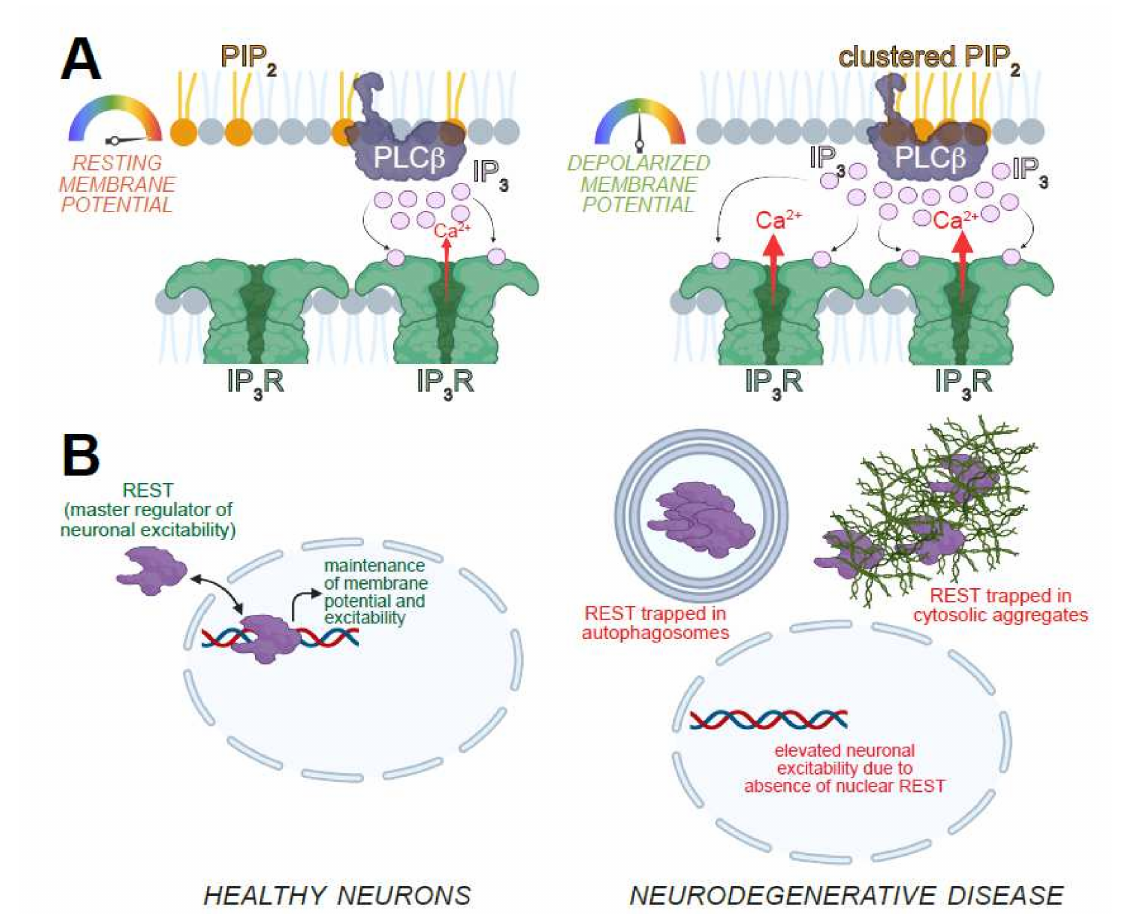
Figure 3. Consequences and regulators of neuronal excitability. ( A ) Left, at resting membrane potentials, PLC β hydrolyzes the PIP 2 moieties associated with the enzyme. Right, plasma membrane depolarization results in enhanced PIP 2 –PLC β clustering. Subsequent, stimulation of PLC β -coupled receptors in depolarized neurons results in the augmentation of PIP 2 hydrolysis, IP 3 production, and IP 3 R-dependent ER Ca 2+ release. ( B ) Left, REST is a master regulator of membrane excitability in healthy neurons. Nuclear translocation of REST allows for the repression of RE1-containing gene such as those encoding channels and pumps. Repression of these genes is necessary for the proper maintenance of membrane potential and excitability. Right, in neurodegenerative disease, REST is sequestered away from the nucleus resulting in derepression of target genes and the augmentation of excitability and genes related to synaptic transmission. Images created with BioRender.com (accessed 25 January